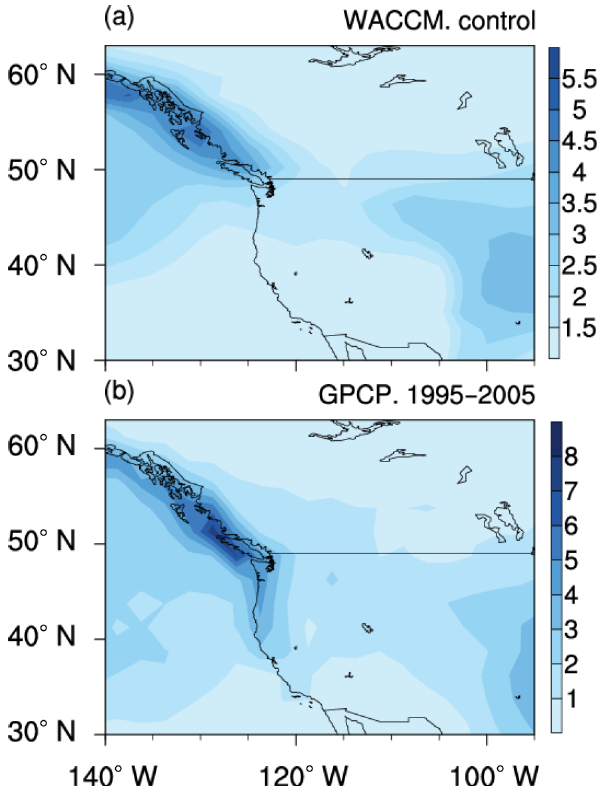
Figure 6. (a) Spatial distribution of April precipitation (mmday − 1 ) climatology in the control experiment (R1). (b) Same as (a) , but precipitation from the GPCP for the period 1995–2005. For details of specific experiments, see Table